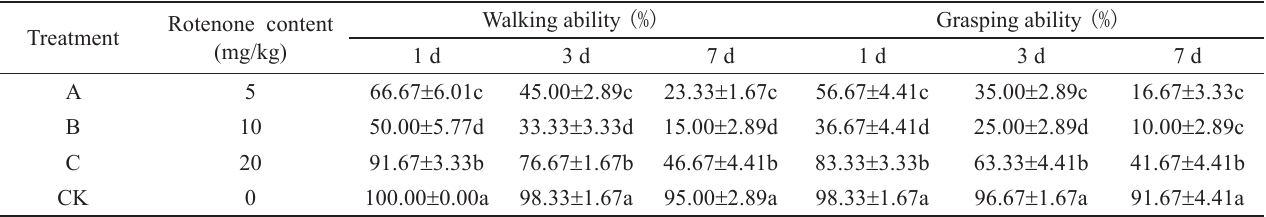
Table 5 . Influences of D. trifoliata root extract, T. vogelii leaf extract, and rotenone on walking and grasping abilities of macroergates of RIFA (Mean ± SE, %)